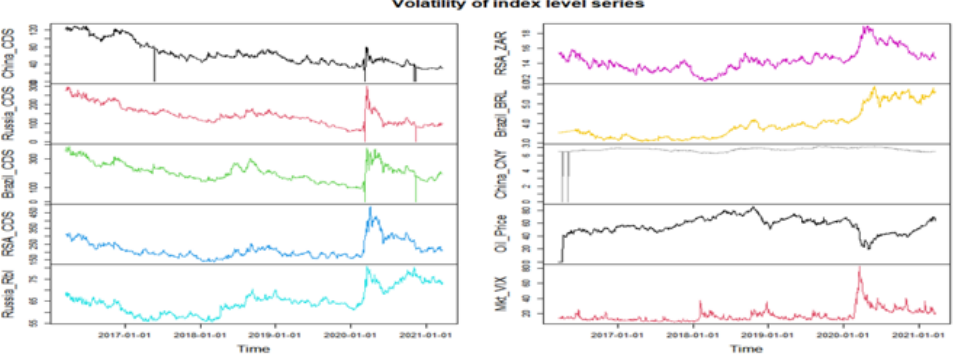
Figure 2. Overview of BRICS sovereign CDS spreads, oil price, exchange rate and global volatility (VIX).